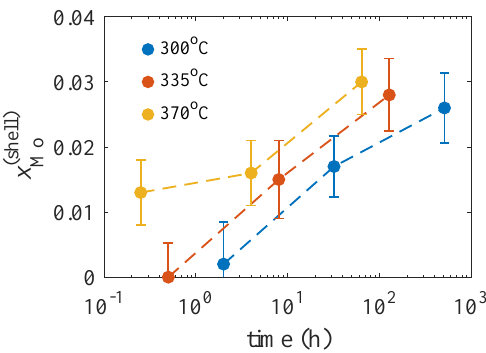
( shell ) in the particle shells as functions of the ageing time and temperature Mo